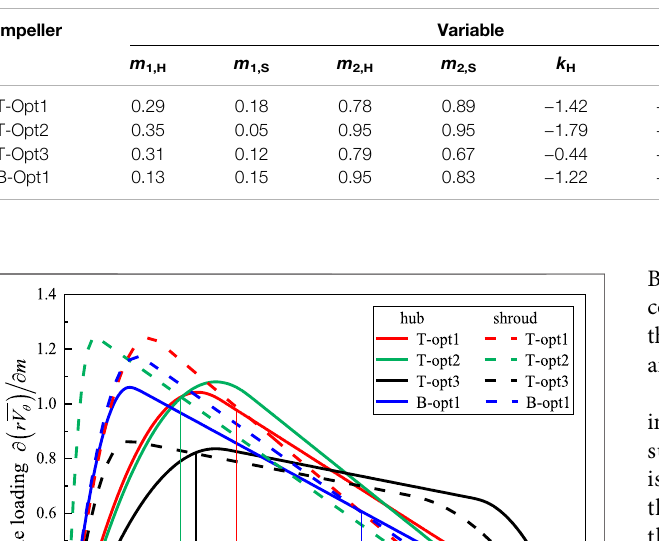
TABLE 4 | Optimization results of impeller blade loading.